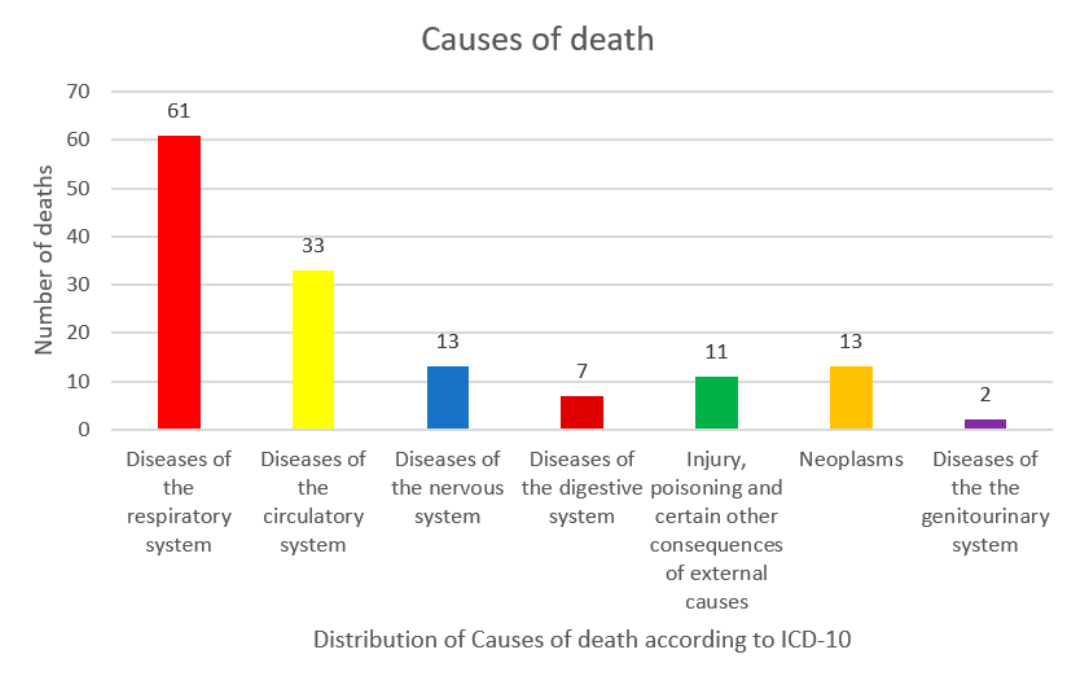
Figure 3. The distribution of causes of death among the 140 hospitalized victims.